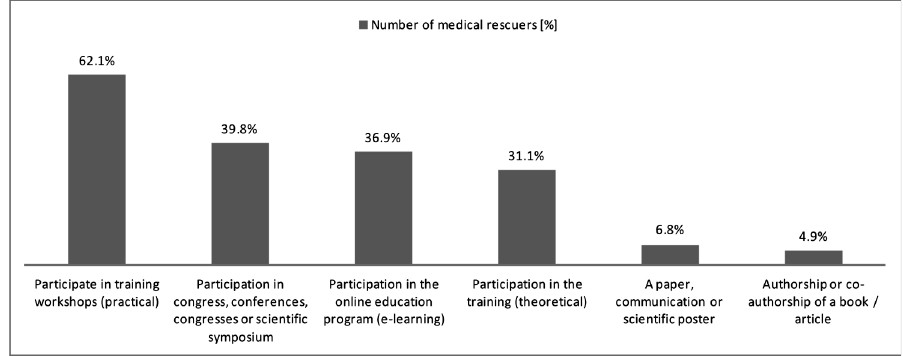
Figure 4. Forms of self-education chosen by paramedics in the previous year Distance learning as a form of professional development . The partici- pants of the survey were willing to choose online sources and seek informa- tion in audio/video recordings (72.8%), on social networking sites (46.6%), in courses on e-learning platforms (43.7%), mobile applications (38.8%), webinars (13.6%), games and computer simulations (6.8%) or even the vir- tual world, for example Second Life (3.9%). A five-point Likert scale ( − 2 , − 1 , 0 , 1 , 2 ) was used to evaluate the effectiveness of e-learning in emer- gency medicine, in which − 2 meant “strongly disagree” while 2 denoted “strongly agree”. As many as 69.9% of the respondents stated that e-learning education is effective in emergency medicine (items 1 and 2) and only